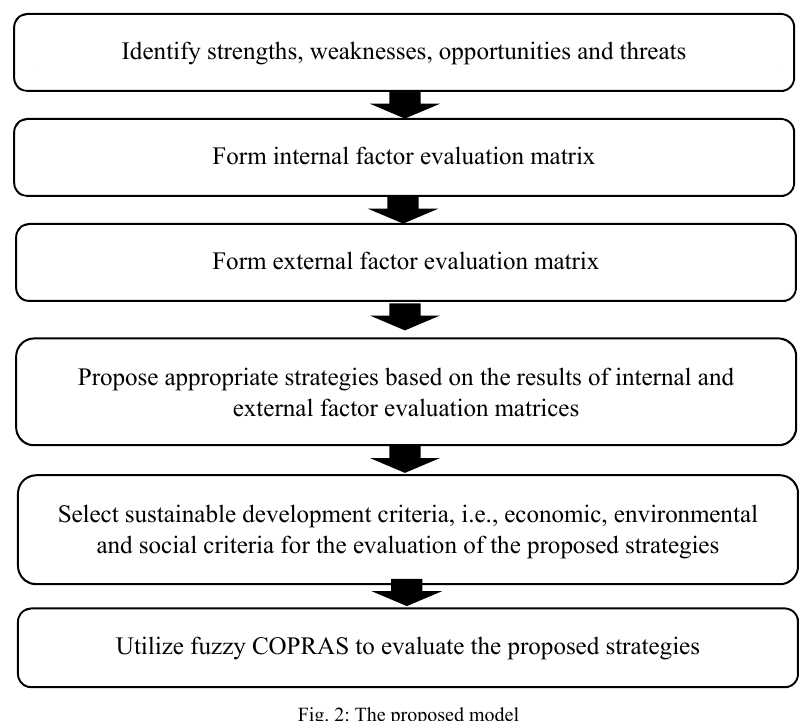
Fig. 2: The proposed model